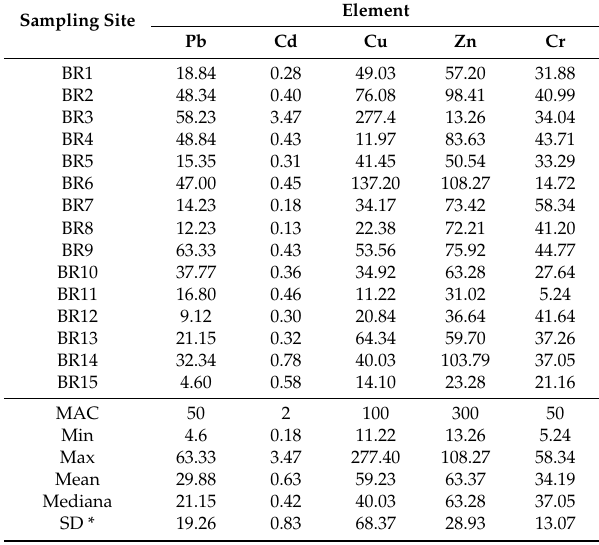
Table 6. Total contents and descriptive statistics of elements in Bar (BR) urban parks soil samples for this study (mg ¨ kg ´ 1 ).